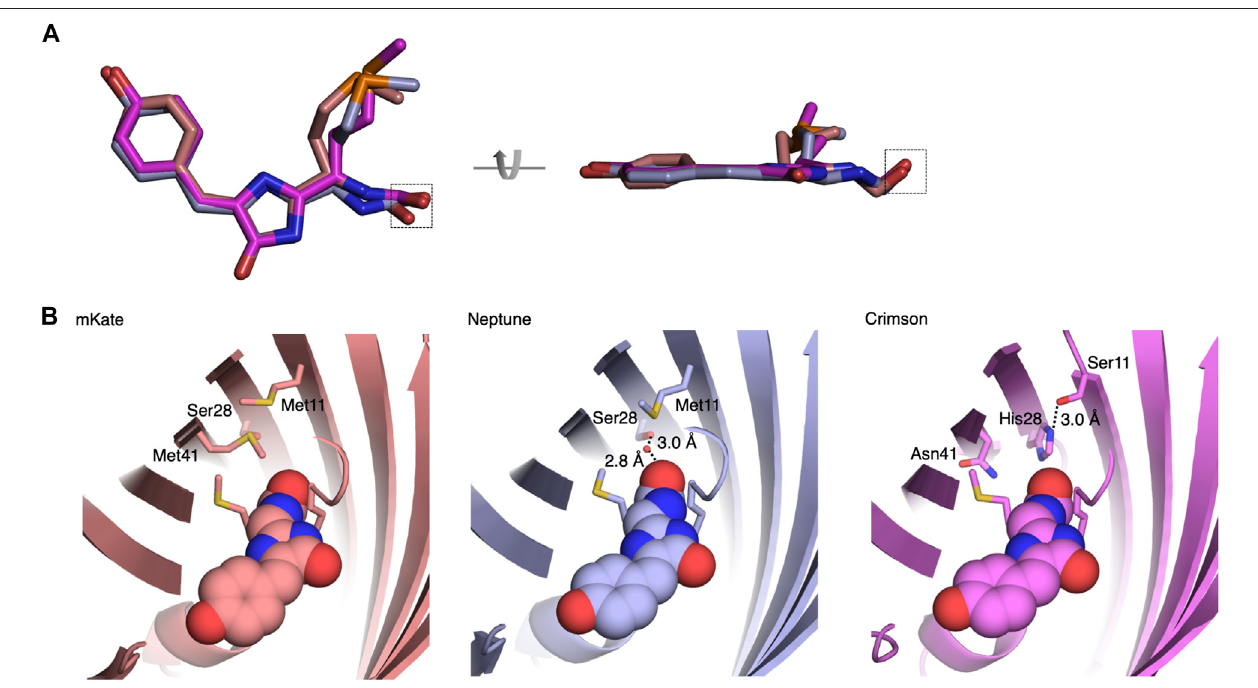
FIGURE2| Structuralbasisofblue-shiftingforAsn41,His28, andSer11inCrimson. (A) AlignmentofCrimson (magenta), Neptune (PDBentry3IP2,lightblue)and mKate (PDB entry 3BXC, pink) chromophores. The chromophore rings are more coplanar in Crimson or Neptune than in mKate. The chromophore acylimine oxygen is indicated by the dashed box. (B) Hydrogen-bond interactions between the chromophore acylimine oxygen and its surrounding residues in Crimson, mKate and Neptune. In mKate, the acylimine oxygen does not engage in any hydrogen bond interactions. In Neptune, a water molecule donates a hydrogen bond to the acylimine oxygen and accepts a hydrogen bond from Ser-28. In Crimson, a hydrogen bond between Ser-11 and His-28 precludes one between His-28 and the acylimine oxygen. In addition, the side chain of Asn-41 is too short to hydrogen bond to the acylimine oxygen.